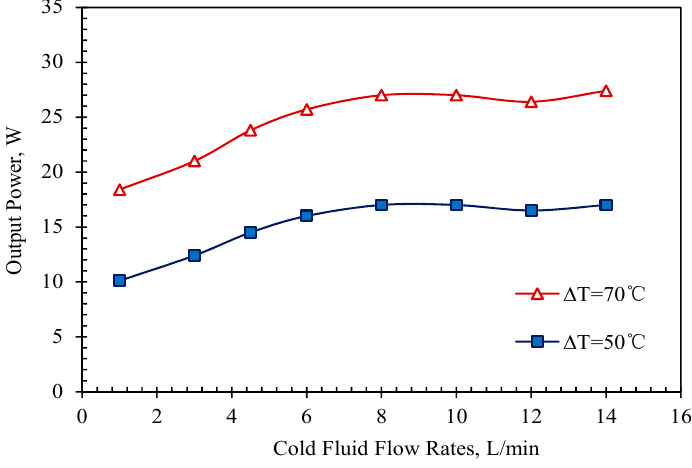
Figure 14. The effect of cold fluid flow rate on output power.